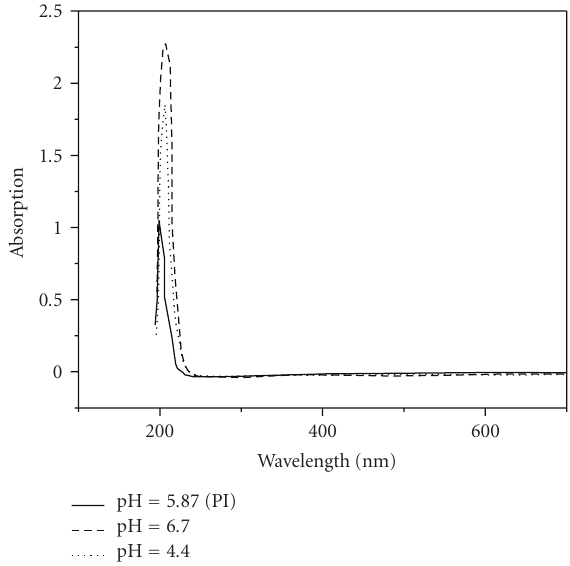
Figure 27: Powder SHG e ffi ciencies of L-threonine at di ff erent pH